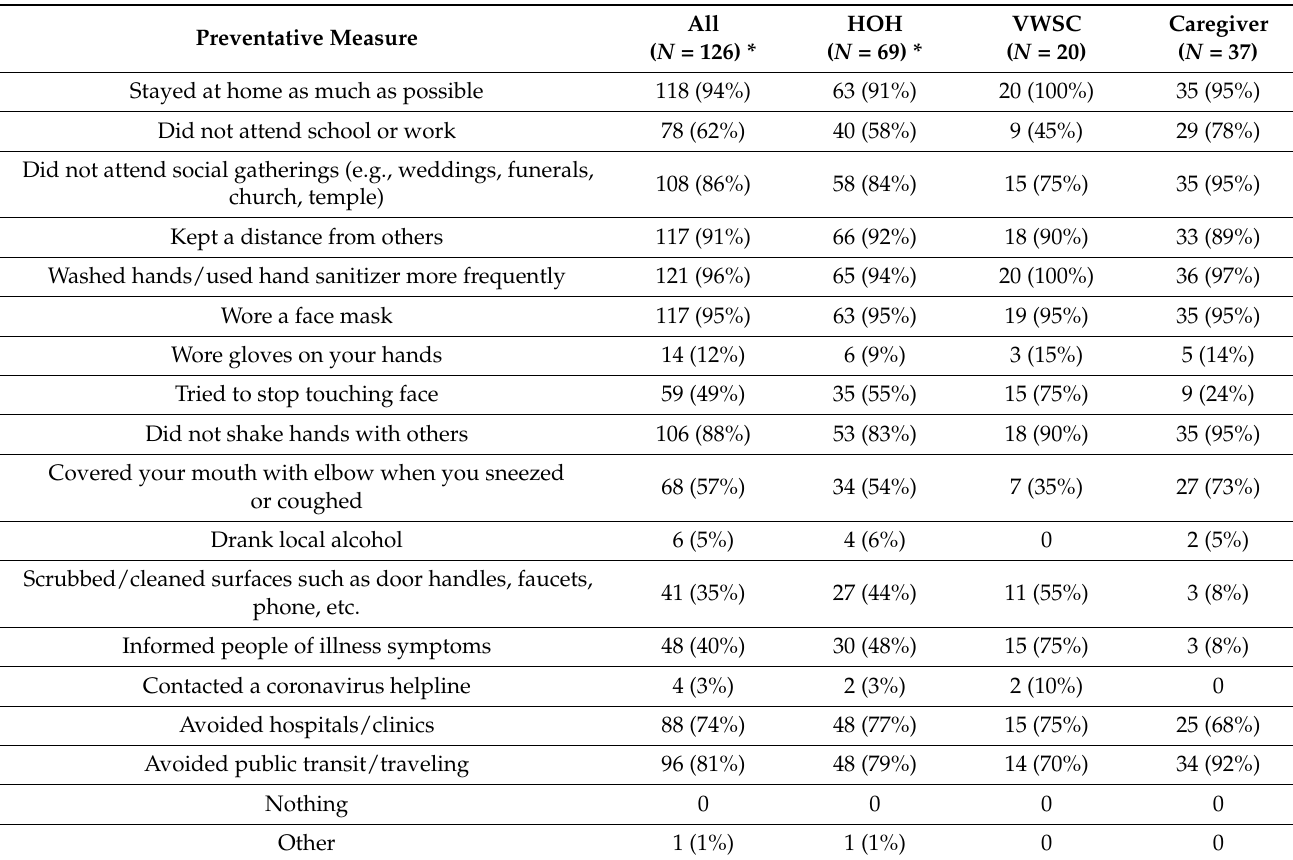
Table 2. Preventative measures reported by respondents when asked “In the past seven days, what actions have you and your family taken to avoid getting coronavirus, if any?” with each action read as a structured yes/no